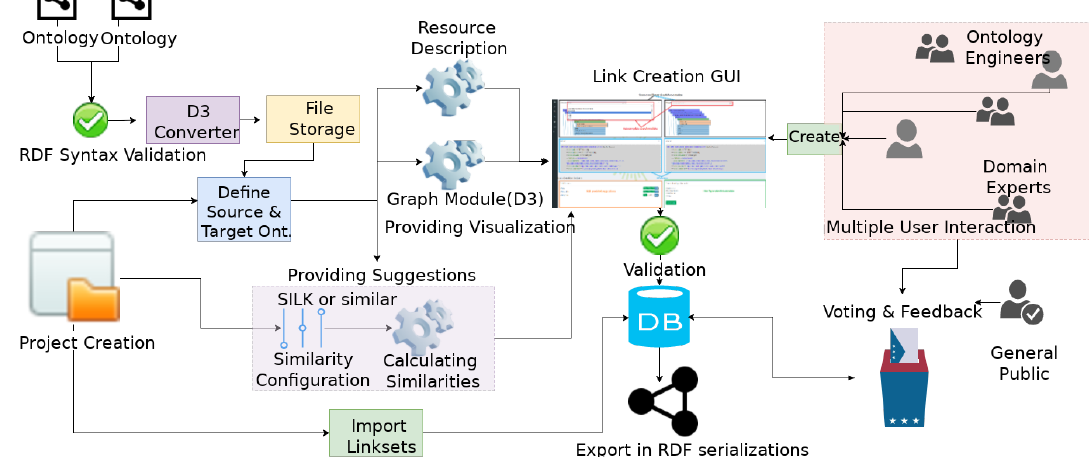
Figure 1. Alignment